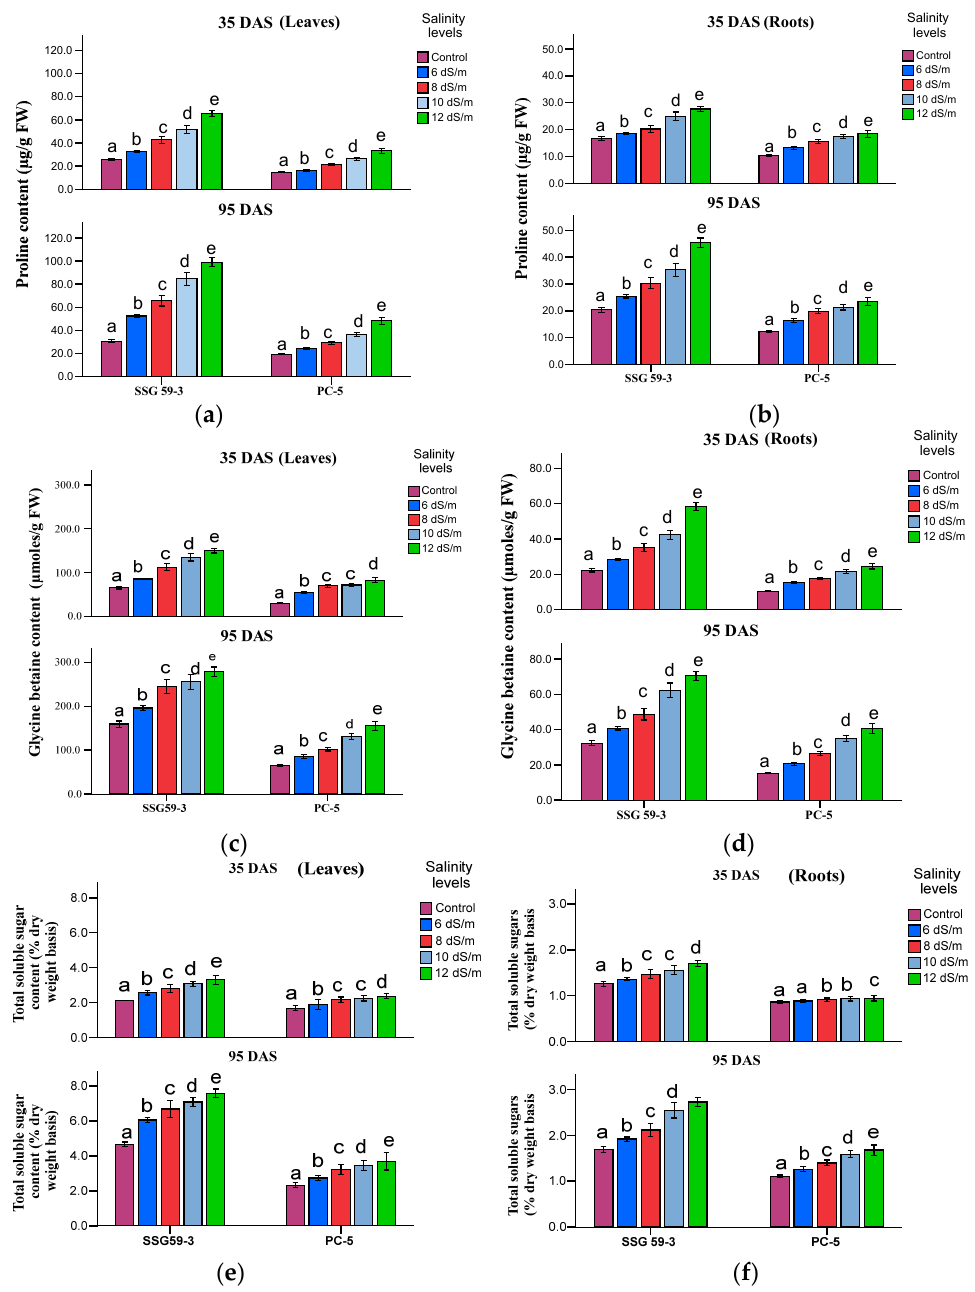
Figure 10. Effect of salt stress on proline (Pro, ( a , b )), glycine betaine (GB, ( c , d )), and total soluble carbohydrates (TSC, ( e , f )) of sorghum genotypes at 35 and 95 DAS. Post hoc comparisons of the means were performed using Tukey’s HSD test at p < 0.05; different letters ( a–e ) indicate significant differences among treatments within each genotype.